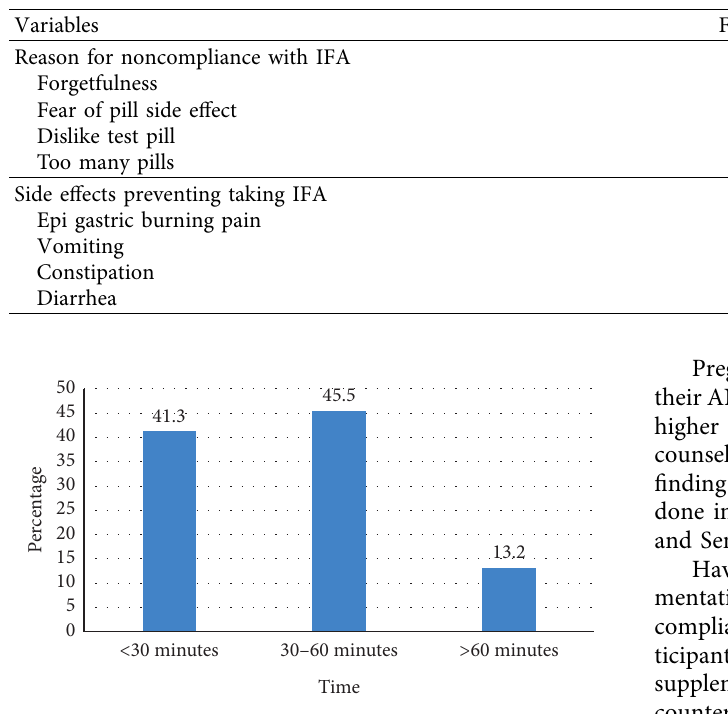
Table 3: Reason for noncompliance with iron-folate supplements among pregnant women attending antenatal care and taking iron-folate, Shalla district health facilities, West Arsi Zone, Southwest Ethiopia, 2019 ( N � 402).